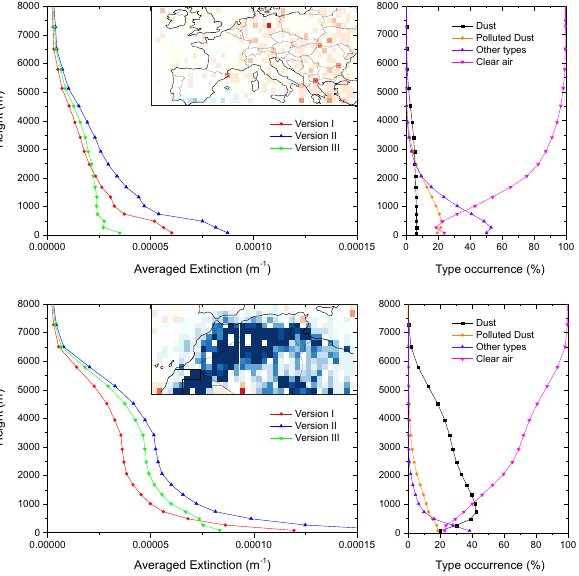
Fig. 12. Comparison between Level 3 extinction CALIPSO product for the three versions presented here. Upper: averaged extinction profiles over Europe (left) and type occurrence frequency (right). Lower: averaged extinction profile over northern Africa (left) and type occurrence frequency